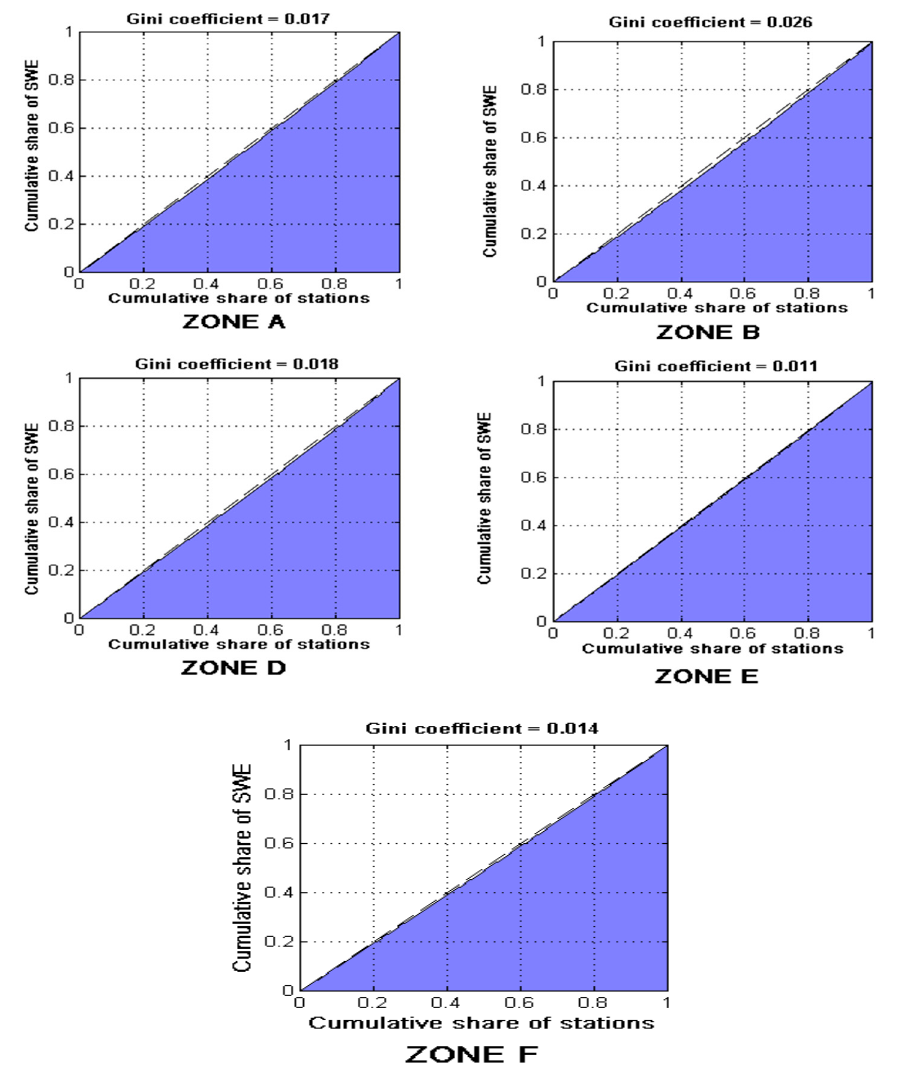
Figure 5. Lorenz curves and Gini coefficient of zones A, B, D, E, and F at the regional scale .